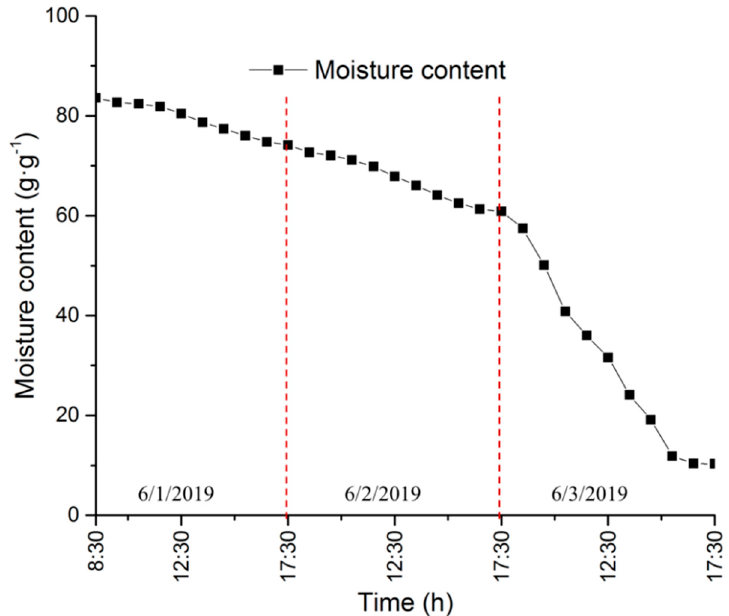
Figure 13. The variation of lemon slice moisture content.